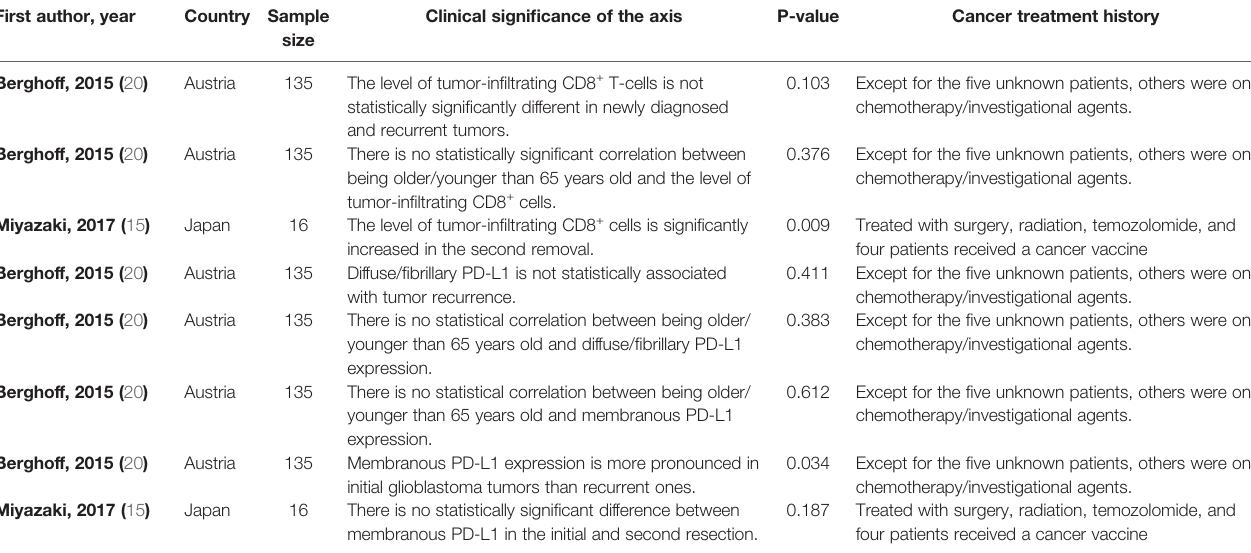
TABLE 2 | The clinical signi fi cance of tumor-in fi ltrating CD8 + T-cells/PD-L1 axis in high-grade glioma